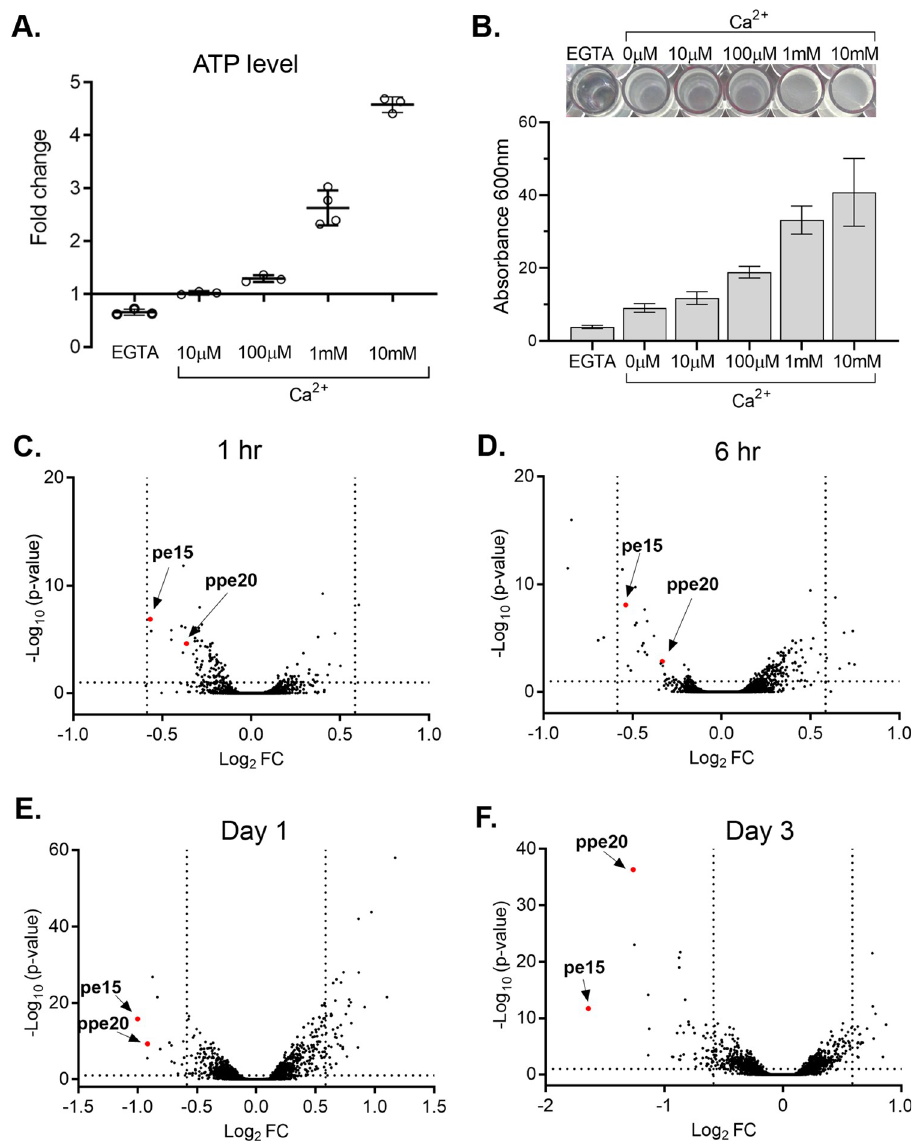
Fig 1. Ca 2+ affects Mtb cellular processes and down-regulates pe15 and ppe20 transcripts. (A) Effect of Ca 2+ on cellular ATP levels. Mtb was grown in detergent-free CTSM containing increasing concentration of Ca 2+ (10 μ m–10 mM) or 1 mM EGTA at 37˚C, treated with 0.1% Tween-80 and ATP was quantified using BacTiter-Glo reagent. Fold change was calculated by comparing to the Ca 2+ -free condition. Data are from biological triplicates, error bars show standard deviation. (B) Ca 2+ promotes biofilm formation. Biofilms were grown in the presence of increasing concentrations of Ca 2+ (10 μ m–10 mM) and 1 mM EGTA and were quantified using crystal violet. The experiment was repeated 3 times and a picture of a representative experiment is shown. Error bars show standard error. RNA-seq analysis of Mtb transcripts after exposure to 1 mM Ca 2+ for (C) 1 h, (D) 6 h, (E) 1 day, (F) 3 days. Significant down- regulation of pe15 and ppe20 transcripts occurred at 1 and 3 days. Few other genes are significantly changed. The data underlying all the plots in this figure are included in S1 Data. Ca 2+ , calcium ion; CTSM, Chelex-treated Sauton’s